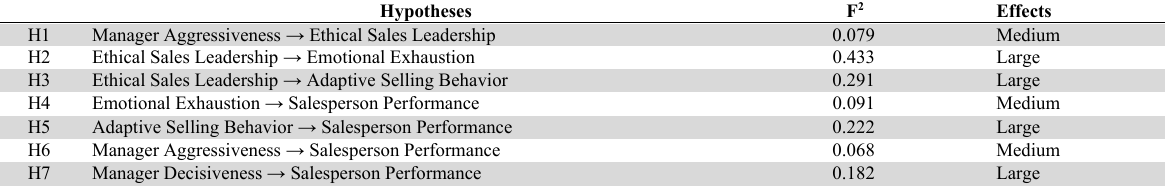
Effect size (F 2 ) statistics for the general model.